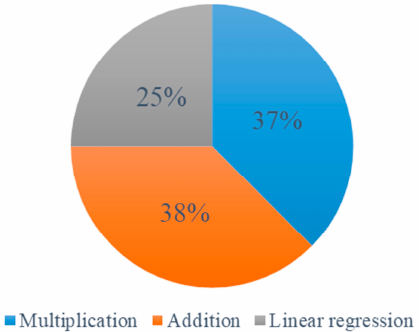
Figure 8. Distribution of tested adjustment methods for Type-2.